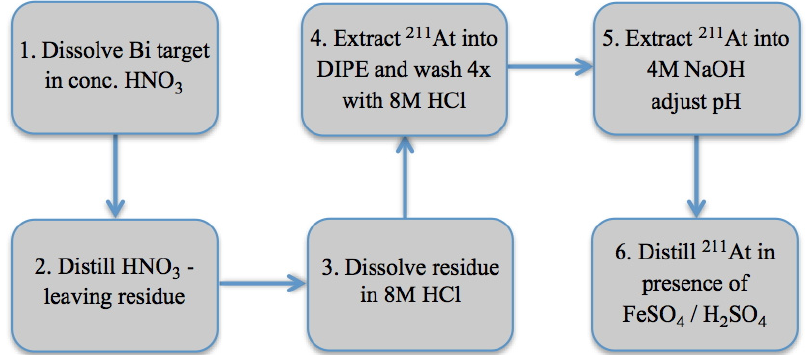
Figure 1. Steps involved in the “wet chemistry” isolation and purification of 211 At from a 209 Bi target. Note that the isolation process is usually stopped at step 5, but an